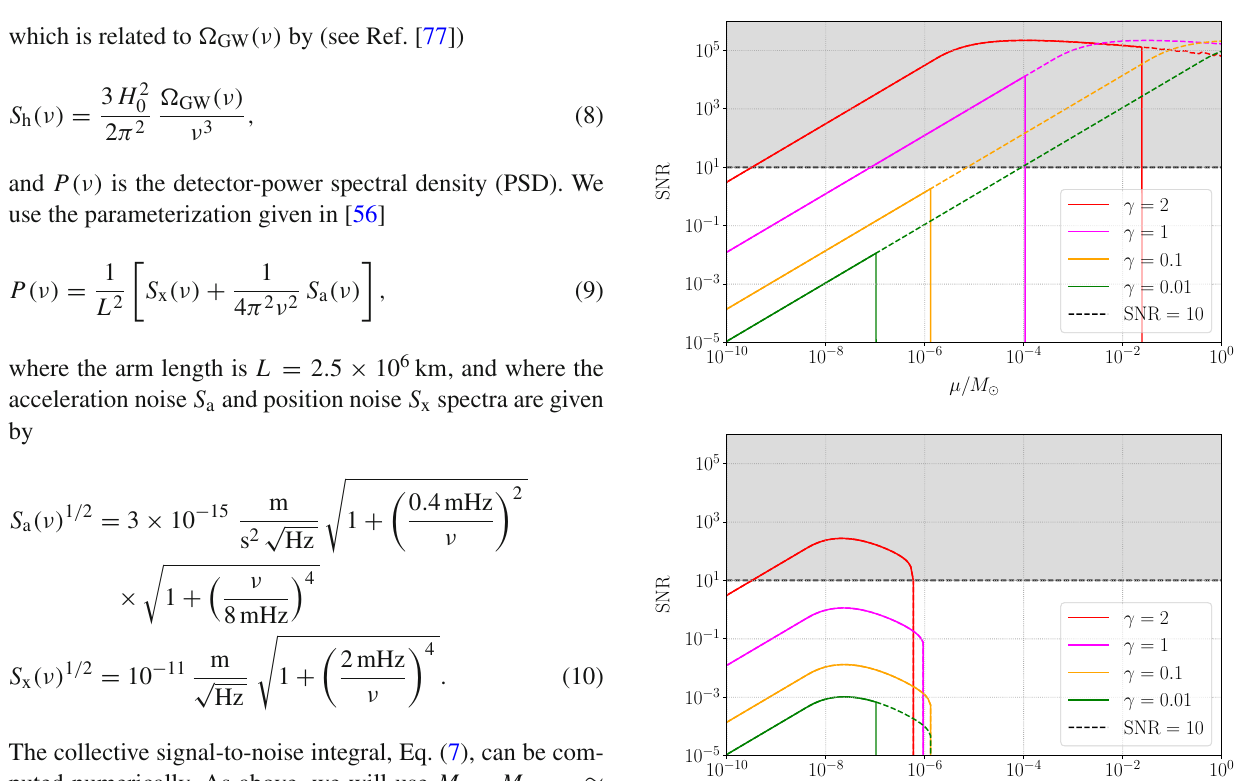
orbits nearest to the black hole are replenished, and on the details of the dark-matter spike (if any). In this work we have aimed at a conservative estimate of the gravitational- wave emission. There are several approximations we have made which can be improved in future work. First, due to the shape of the LISA power spectrum, the SNR is dominated by frequencies near 1 mHz. In practice, this means that the sig- nal is dominated by the orbits very close to the central black hole, which are relativistic ( v/ c > 0 . 1). In future work it will be interesting to explore the effect of relativistic corrections. We have also ignored effects of inclination relative to the observer, which we expect could introduce an O ( 1 ) factor into the final result. Reference [80] has placed constraints on the power law index for the dark-matter spike using obser- vations of stellar orbits (see also Refs. [81,82]). However, because these observations are sensitive to the behavior of the spike at distances of order ten parsecs or greater from the Galactic Centre, these observations do not rule out the